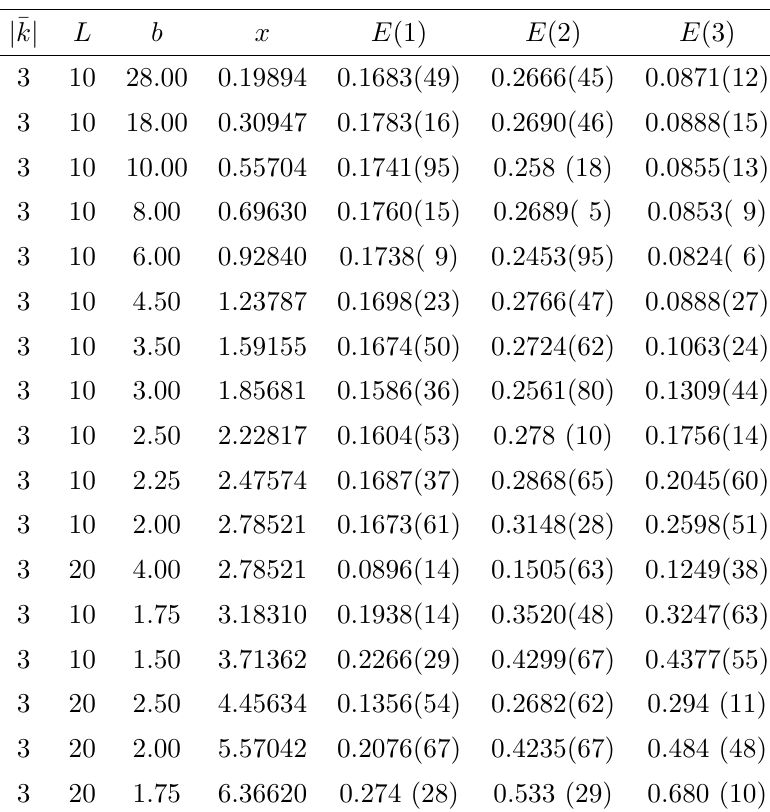
Table 5. SU(7) torelon energies (in lattice units)